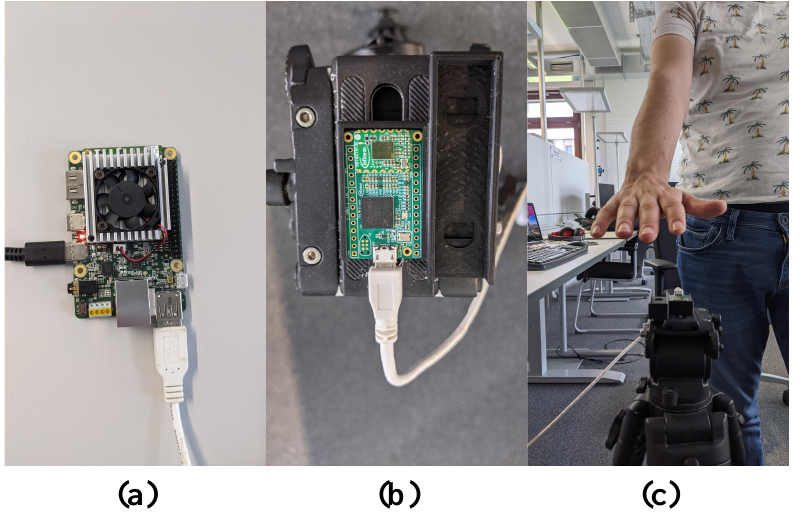
Figure 13. Inference setup; ( a ) Coral Edge TPU; ( b ) 3D-printed case and radar board; and ( c ) tripod with 3D-printed case and radar board.